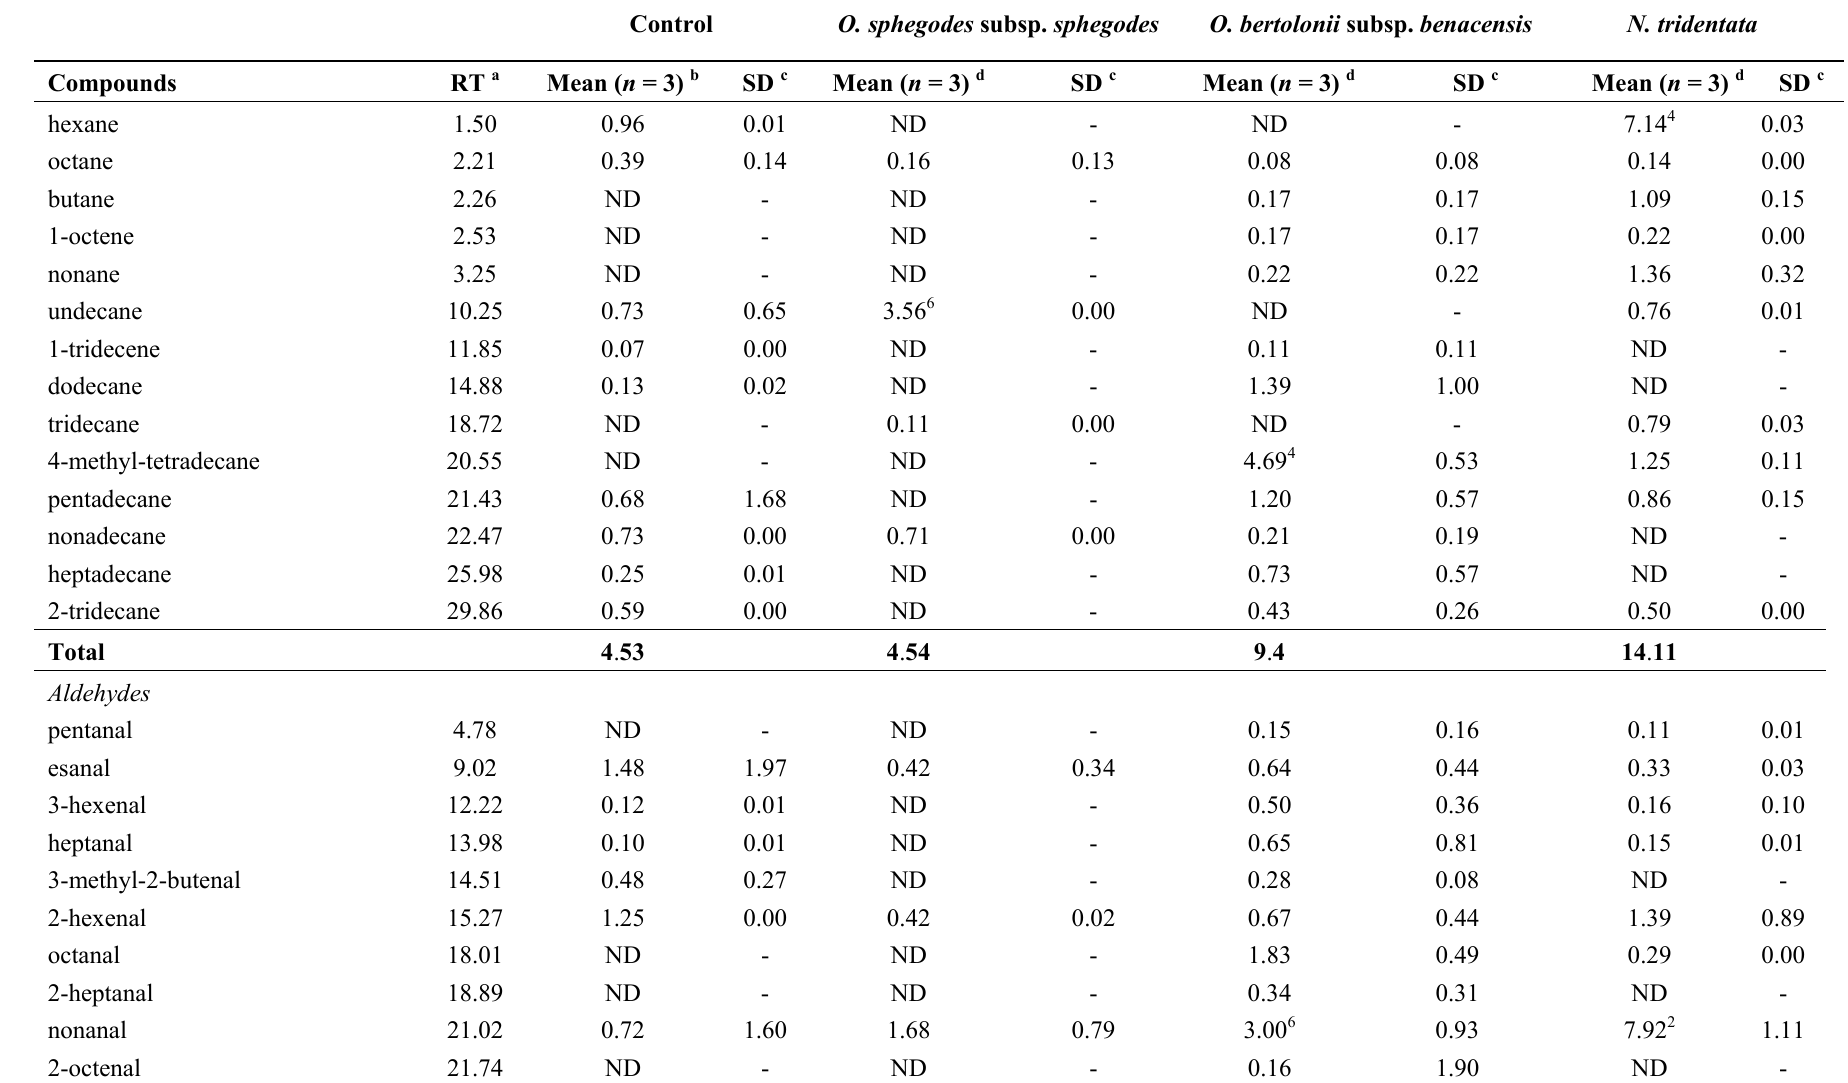
Table 1. Identification of volatile organic compounds by HS-SPME-GCMS from “ in vivo ” orchids. Control O. sphegodes subsp.